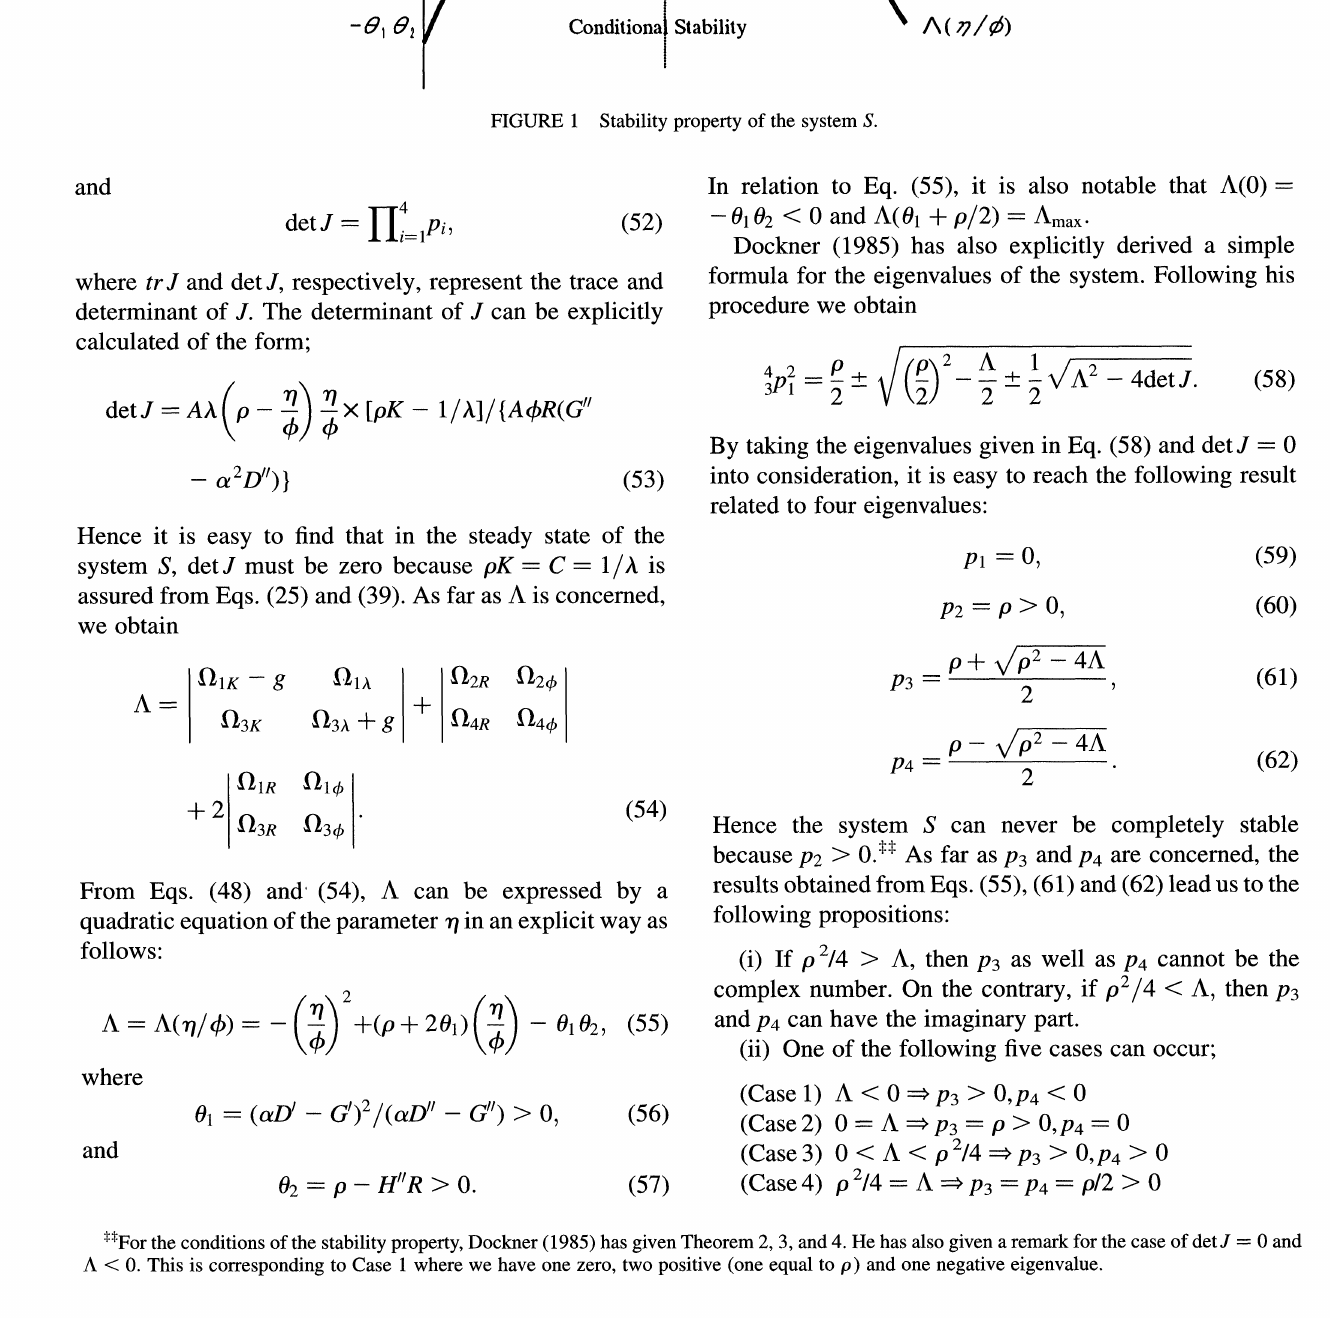
FIGURE Stability property of the system